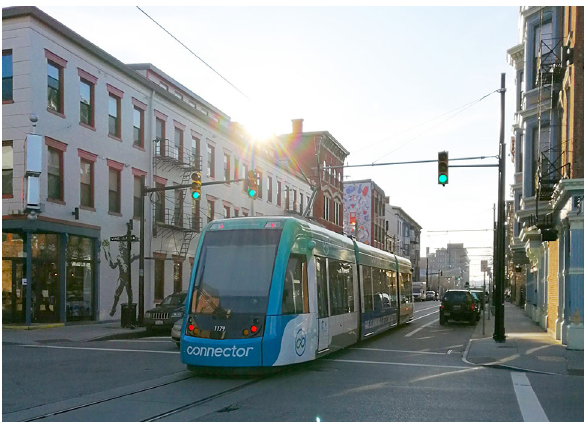
Fig. 6 The tram line in the city. Source :